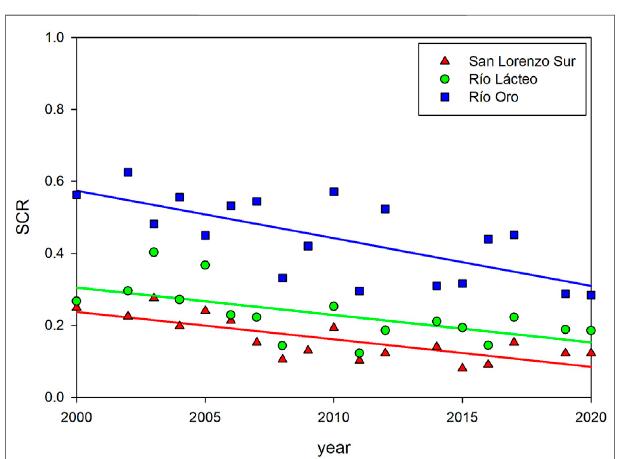
FIGURE 7 | Scatter plot showing Snow Cover Ratios (SCR) for the 2000 – 2020 period. Note the absence of data for years 2013 and 2018.